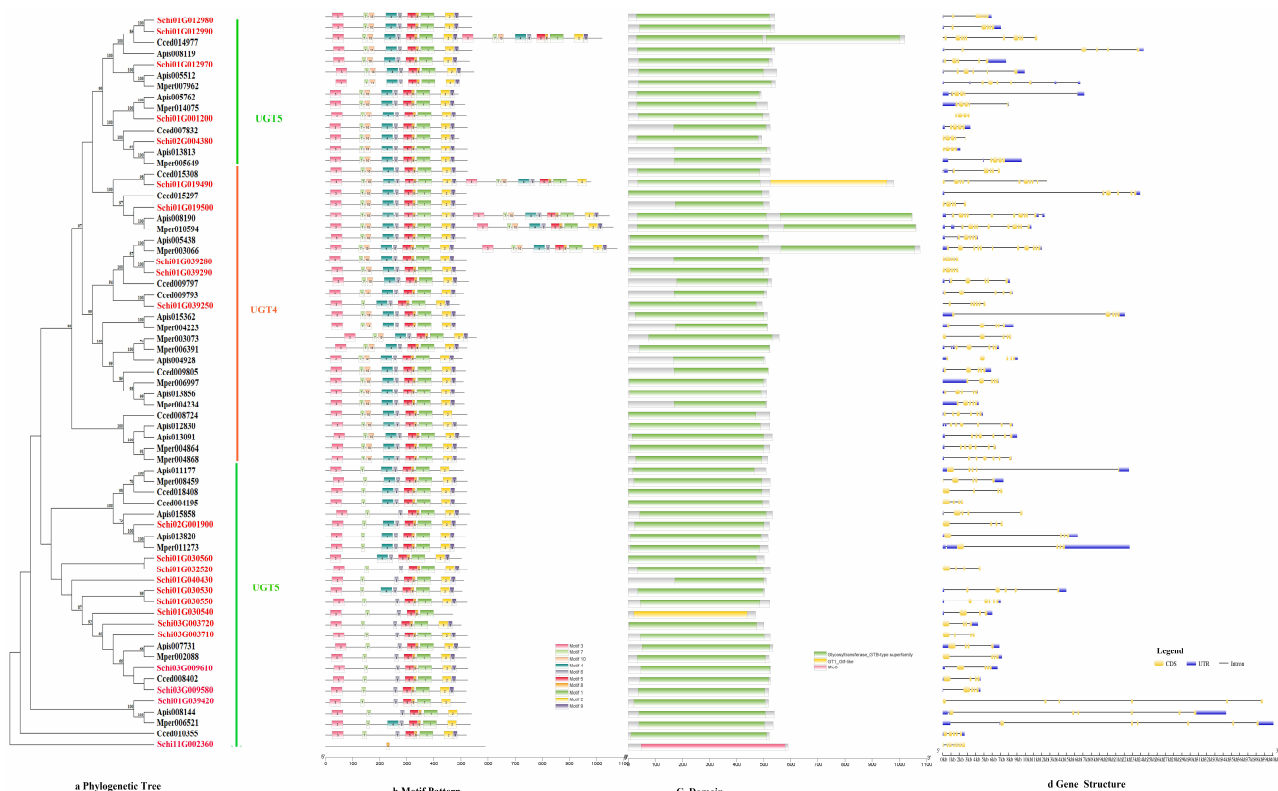
Figure 4. ( a ) Phylogenetic relationships, ( b ) conserved motifs, ( c ) domains and ( d ) gene structures of detoxification genes of the UDP gene family in S. chinensis , A. pisum , C. cedri , and M. persicae .